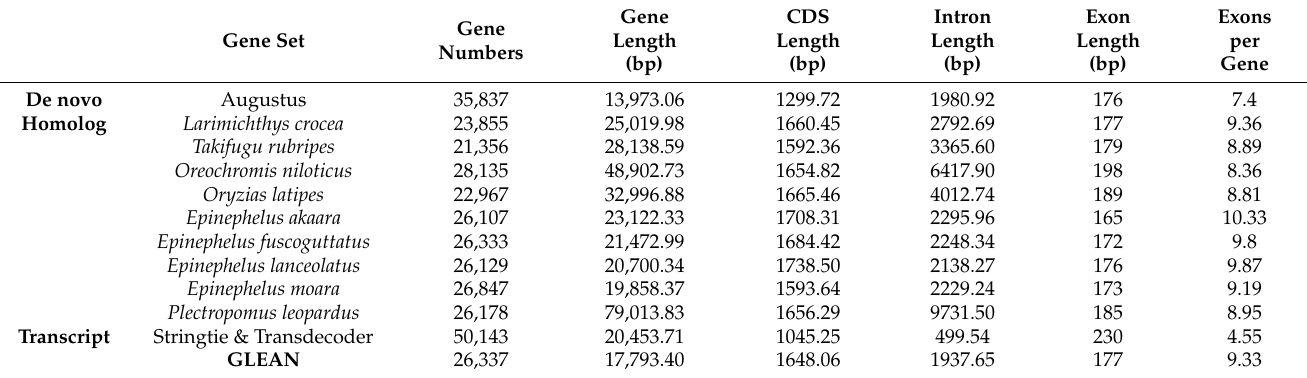
Table 2. Summary statistics of predicted protein-coding genes in E. cyanopodus .